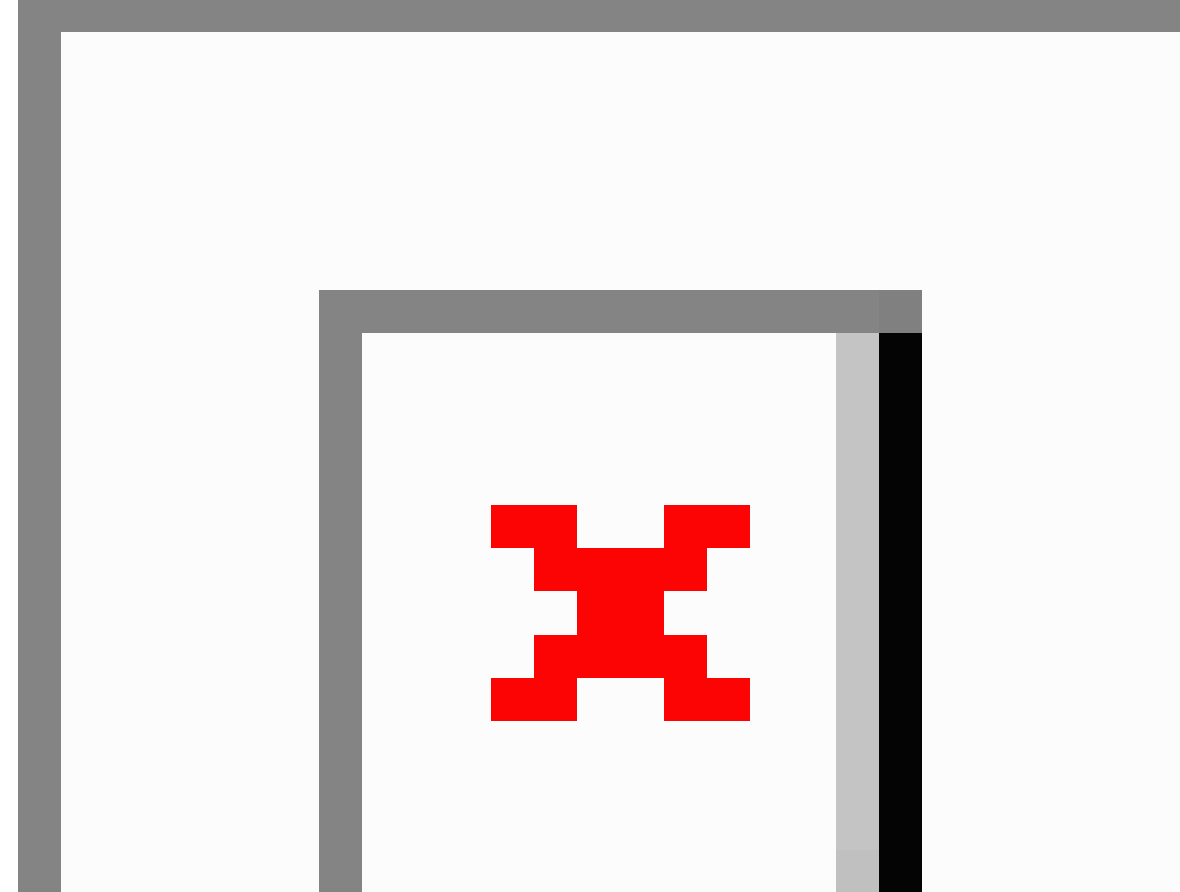
Figure 3. Citation matrix of previously published observational studies included in the 15 systematic reviews (all references are available in Multimedia Appendix